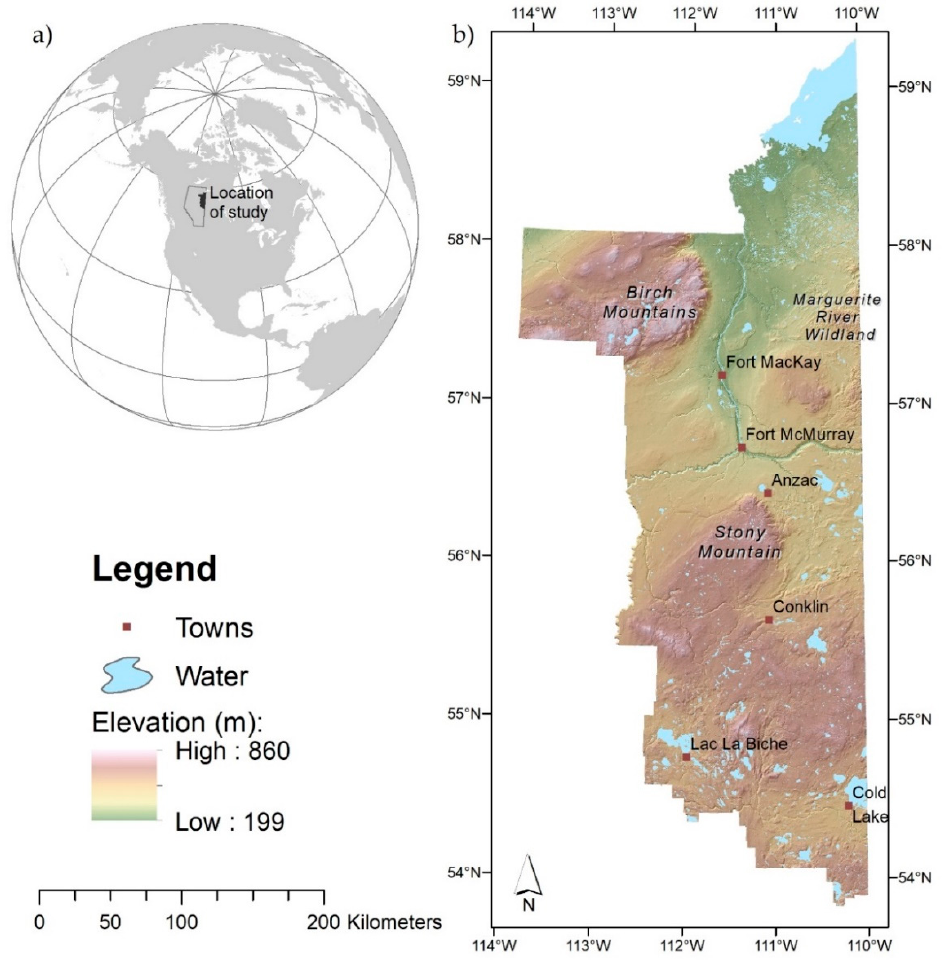
Figure 1. Location of Alberta in western Canada and the study area within North America ( a ); and terrain, elevation, major water features, and place names (towns) for the Lower Athabasca region (south of Lake Athabasca) ( b ).